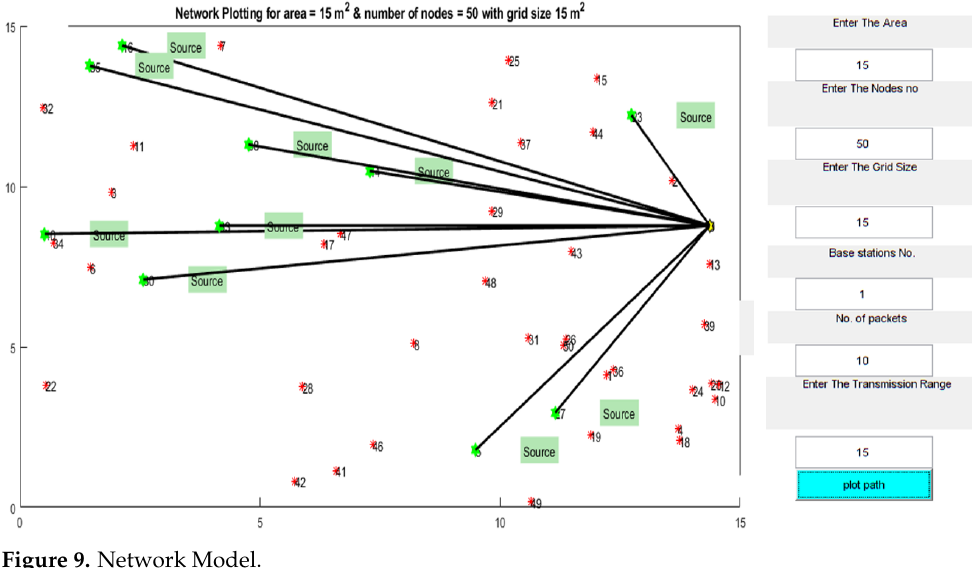
Figure 9. Network Model. Table 7. Operating Voltage, Transmission, Receiving, and Data Rates of Various Devices. Node WDM 500